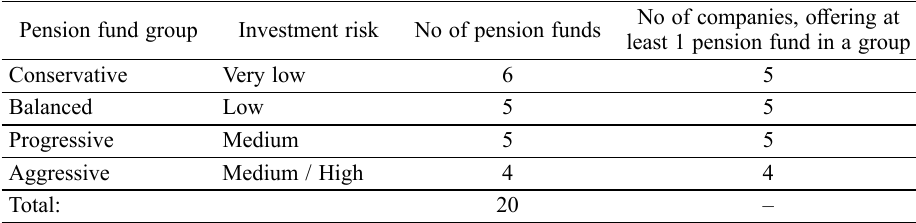
Table 2. Breakdown of second pillar pension funds according to investment risk in Latvia No of companies, offering at least Pension fund group Investment risk No of pension funds 1 pension fund in a group Conservative Very low 8 7 Balanced Low 4 4 Active Medium 8 7 20